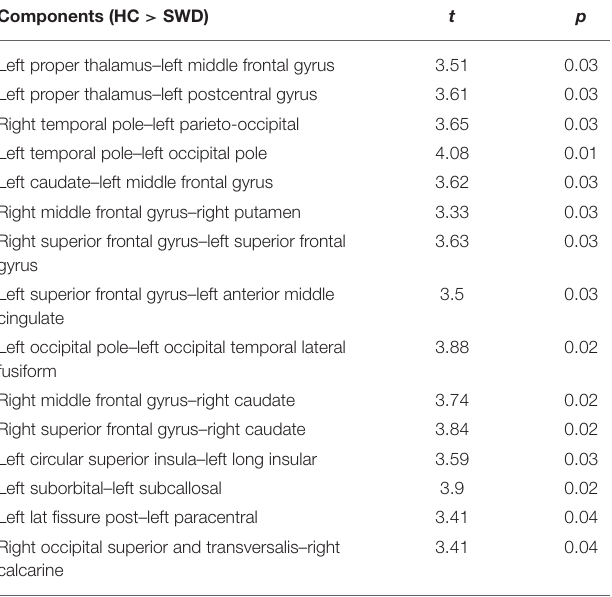
TABLE 2 | Significant components in connectivity matrix between the two